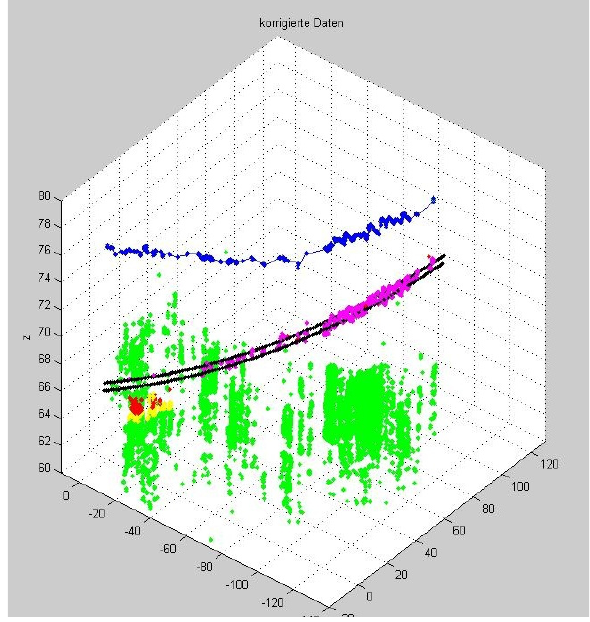
Figure 5. Results with Hokuyo 30LX The top line depicts the path of the drone. The parallel lines below it show the model of the conductor ropes. The fuzzy points on the ropes are real measurements of the ropes. This demonstrated clearly that it is possible to measure them